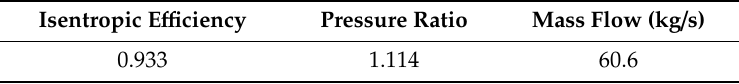
Table 1. Parameters of design-point of the 1.5 stages at 0.6 N.